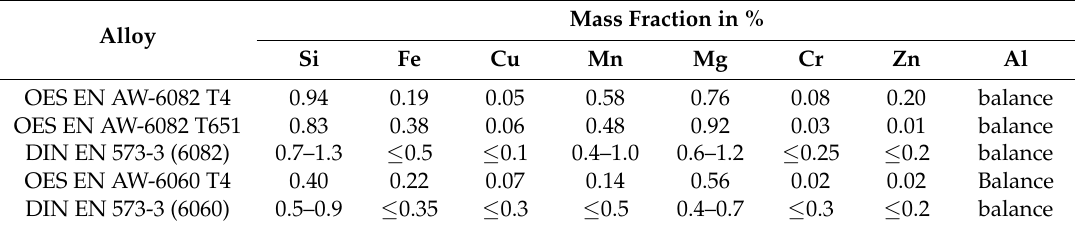
Table 2. Mass fraction of the alloying elements in the investigated alloys in %.